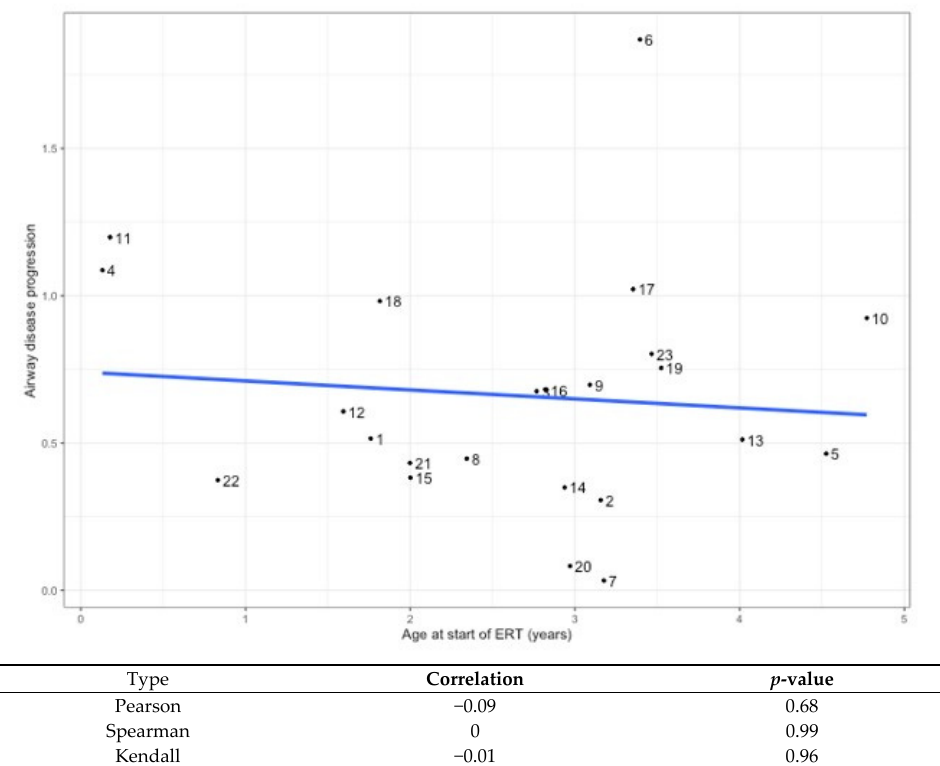
Figure 6. A linear model was fitted with changes in airway severity score as response and age at bronchoscopy as covariate for each one of the n = 23 observations. The number indicates subject ID. The association between airway disease progression and age at start of ERT did not reach statistical significance, as one year increase in age at start of ERT leads to an expected increase of − 0.03 (95% CI: − 0.18, 0.12; p = 0.7) units in the airway disease progression.